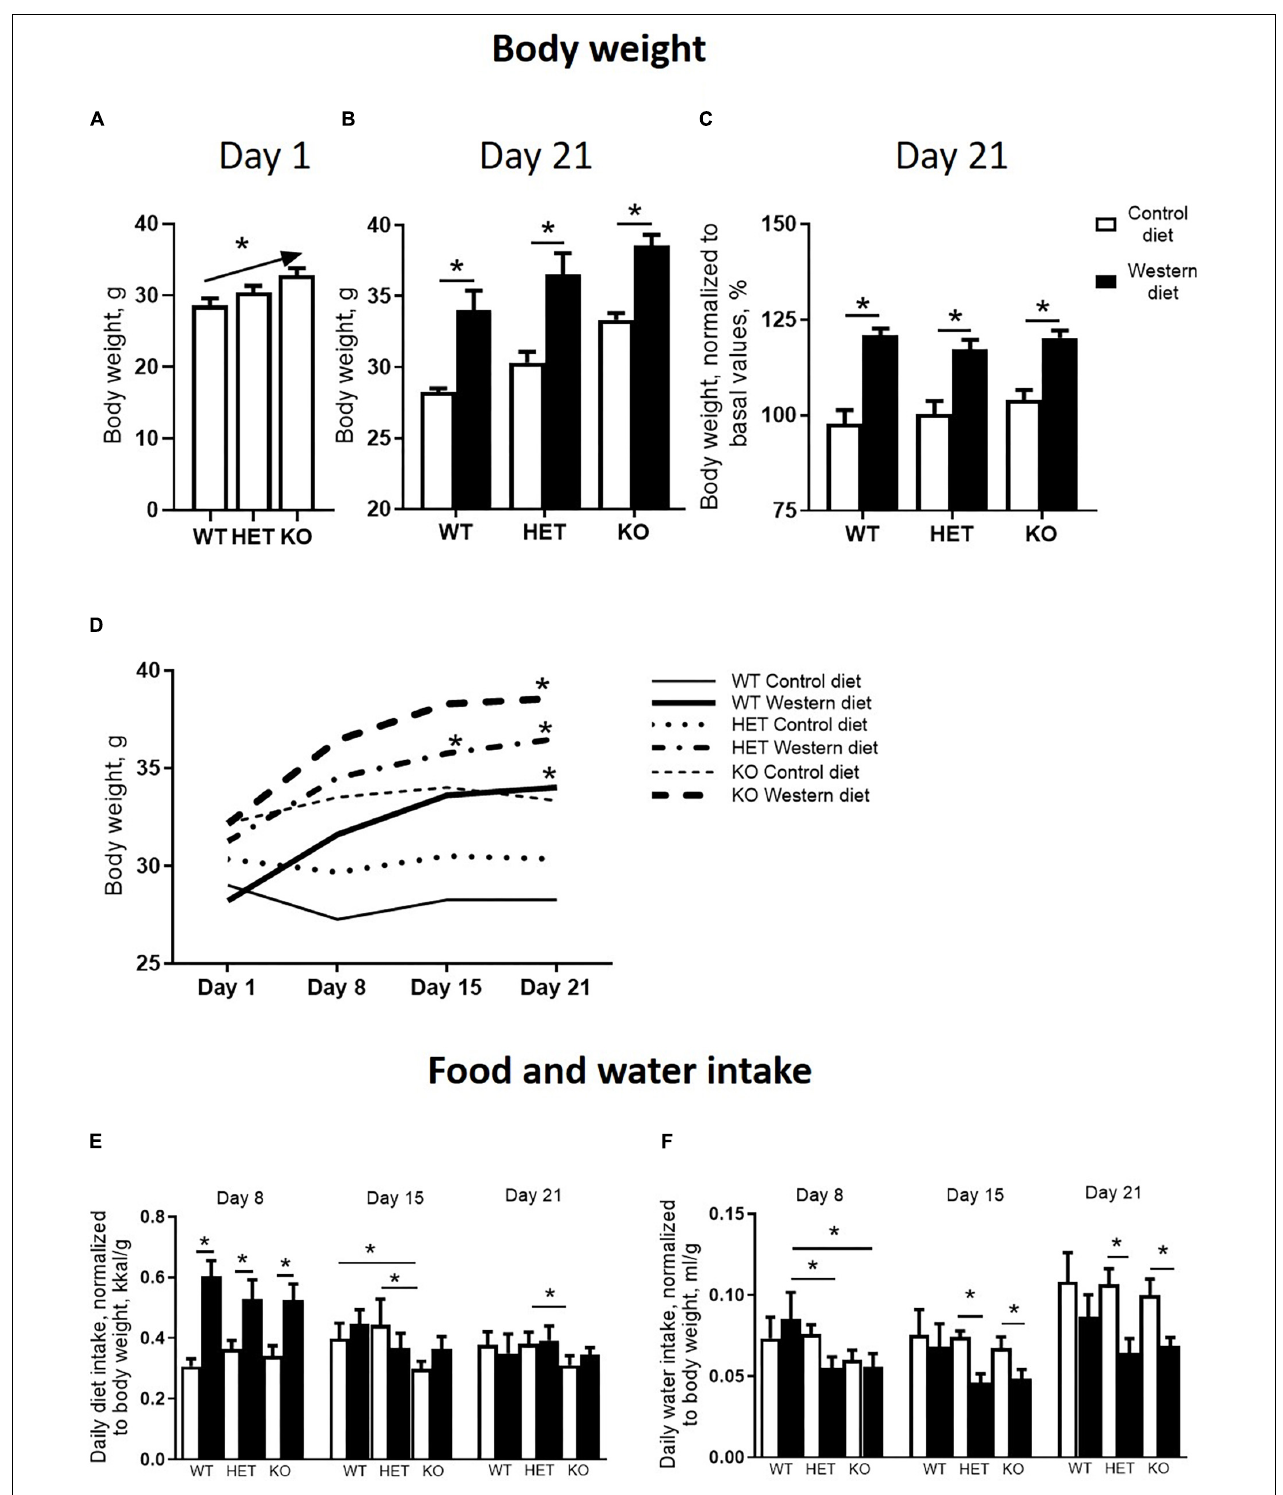
FIGURE 2 | Effects of Western diet feeding on body weight and food and water intake. (A) Basal body weight of mice from different serotonin transporter ( Sert ) genotypes: WT, HET, KO. (B,C) Body weight after 3-week housing on WD or CD in absolute values and normalized to basal body weight. (D) Dynamics of the mouse body weight measured every week during the experiment. Mice fed with WD demonstrated an increase in body weight during the study. (E,F) Diet and water intake. * p < 0.05, one-way ANOVA and post-test for trend panel (A) or two-way ANOVA and Tukey’s test (B–F) , six to seven animals per group were used. Data are shown as mean ± SEM (A–C,E,F) or mean (D)